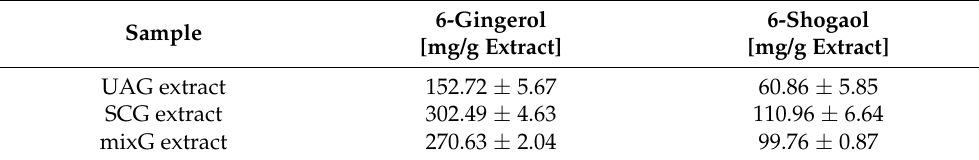
Table 1. Content of 6-gingerol and 6-shoagol in all three prepared ginger extracts (UAG, SCG, and mixG extracts) expressed as mg of each compound per g of the respective extract, determined by the LC-MS/MS